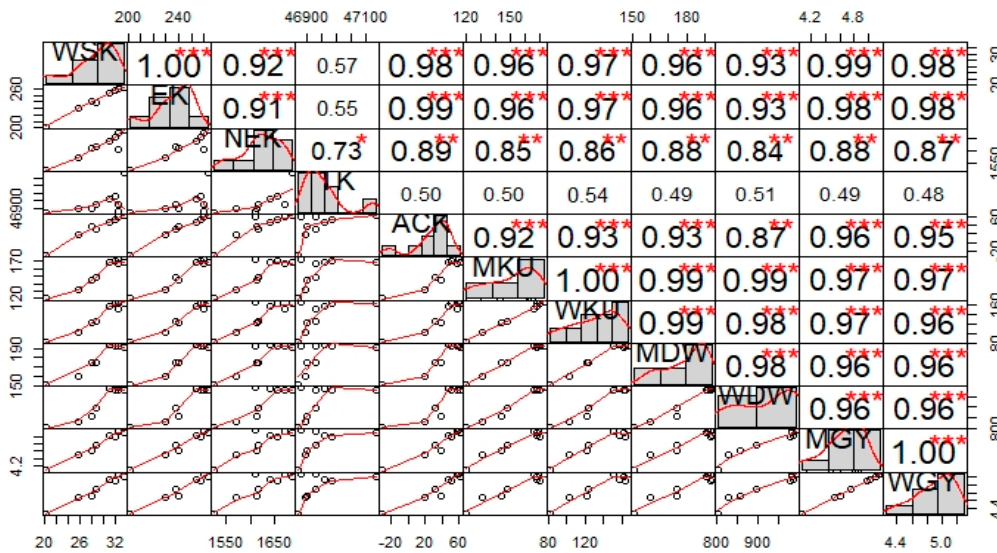
Figure 3. Correlation matrix of maize and wheat yield, K uptake, dry matter, actual K change and native soil K pools (* p ≤ 0.05; ** p ≤ 0.01; *** p ≤ 0.001). WSK: Water Soluble K, EK: Exchangeable K, NEK: Non-Exchangeable K, TK: Total K, ACK: Actual Change in K, MKU: Maize K Uptake, WKU: Wheat K Uptake, MDW: Maize Dry Weight, WDW: Wheat Dry Weight, MGY: Maize Grain Yield, and WGY: Wheat Grain Yield.